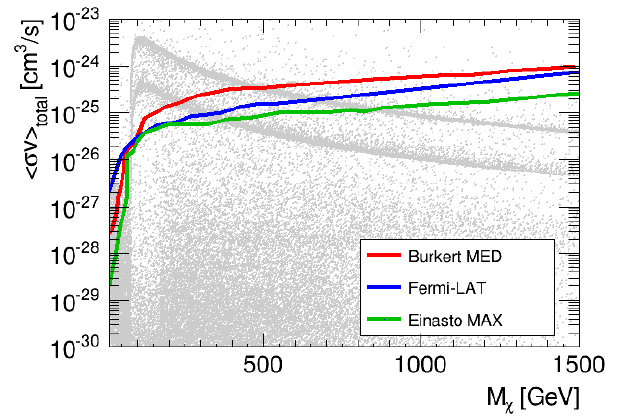
Figure 8 . Points excluded by Fermi-LAT gamma ray and AMS-02 antiproton data in the total annihilation cross section vs. neutralino 1 mass parameter plane. The points above the red line are excluded by AMS-02 data in the conservative case with Burkert pro(cid:12)le and Med propagation model, above the blue line by the Fermi-LAT data, and above the green line by AMS-02 data in the stringent case with Einasto pro(cid:12)le and Max propagation